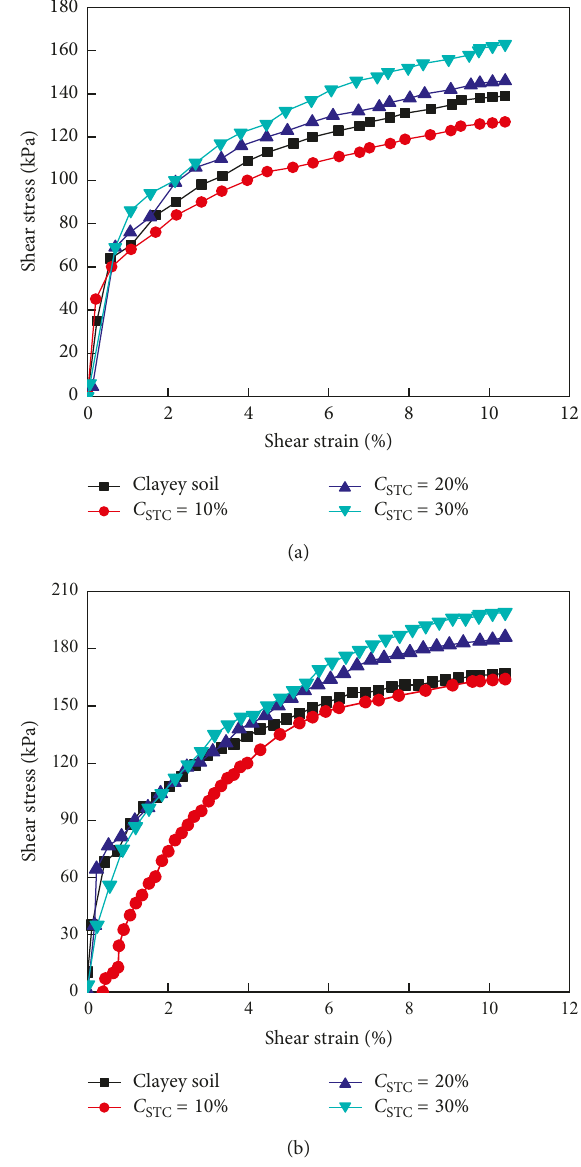
Figure 8: Shear stress-shear strain curves for mixtures under vertical pressure of 200kPa. (a) Shear rate of 0.8mm/min. (b) Shear rate of 0.1